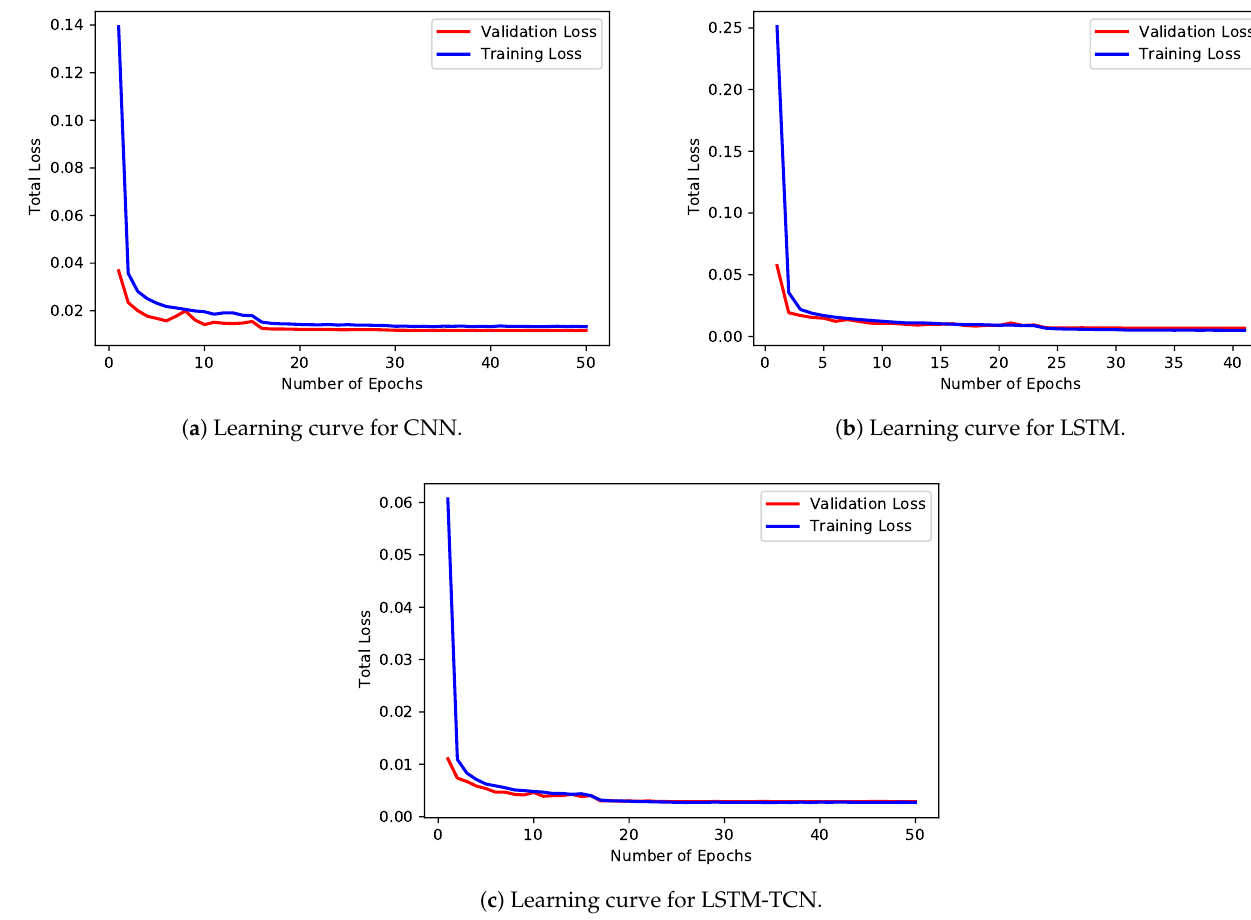
( c ) Learning curve for LSTM-TCN. Figure 7. Learning curves in the IEEE 14-bus system under L 2 -norm =